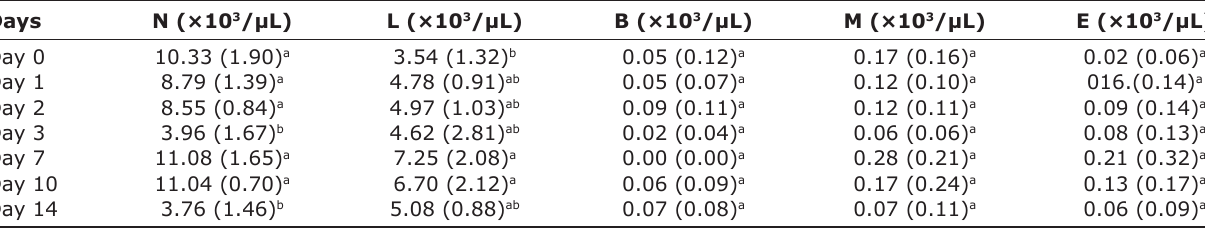
Table 4: Changes in the mean DWBC of CPDA-1 SCB PS.